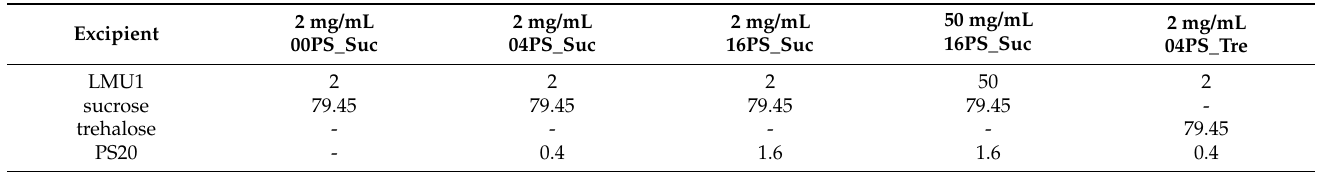
Table 1. Used formulations. Concentrations given in mg/mL.